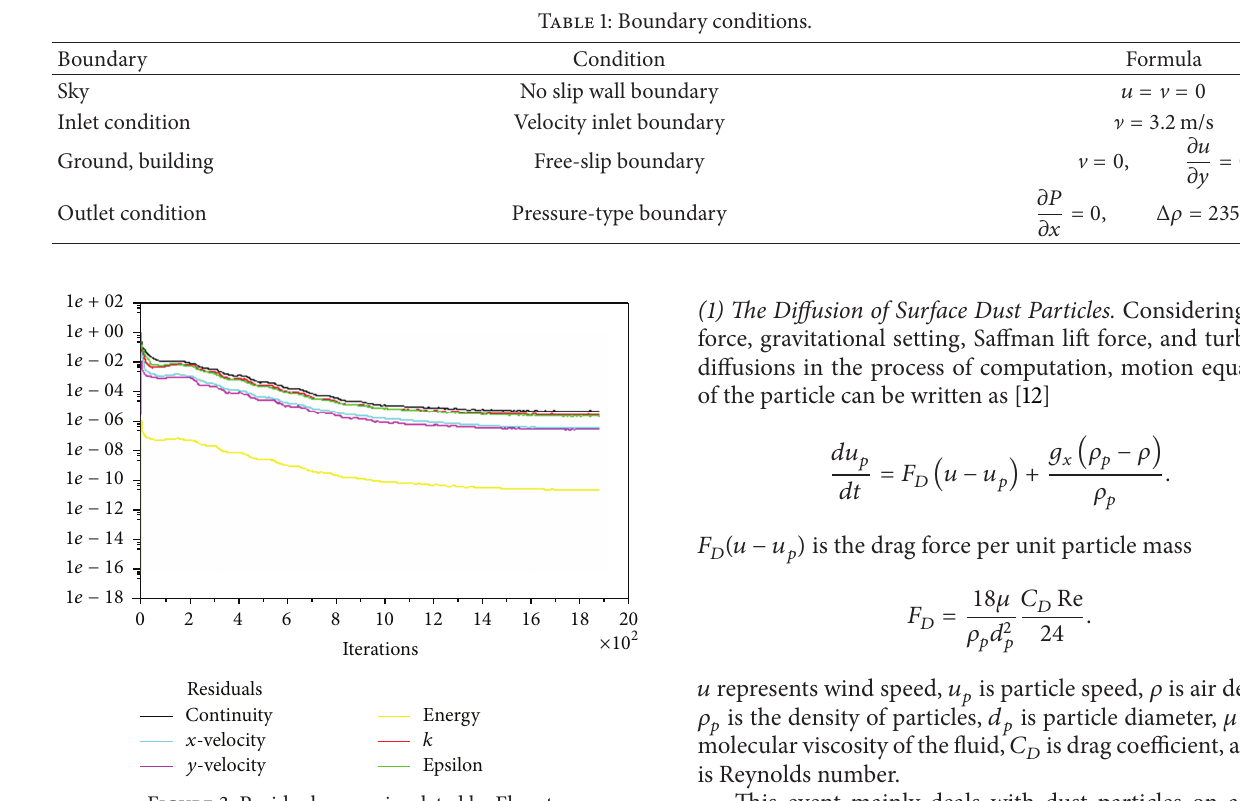
Figure 3: Residual curve simulated by Fluent.